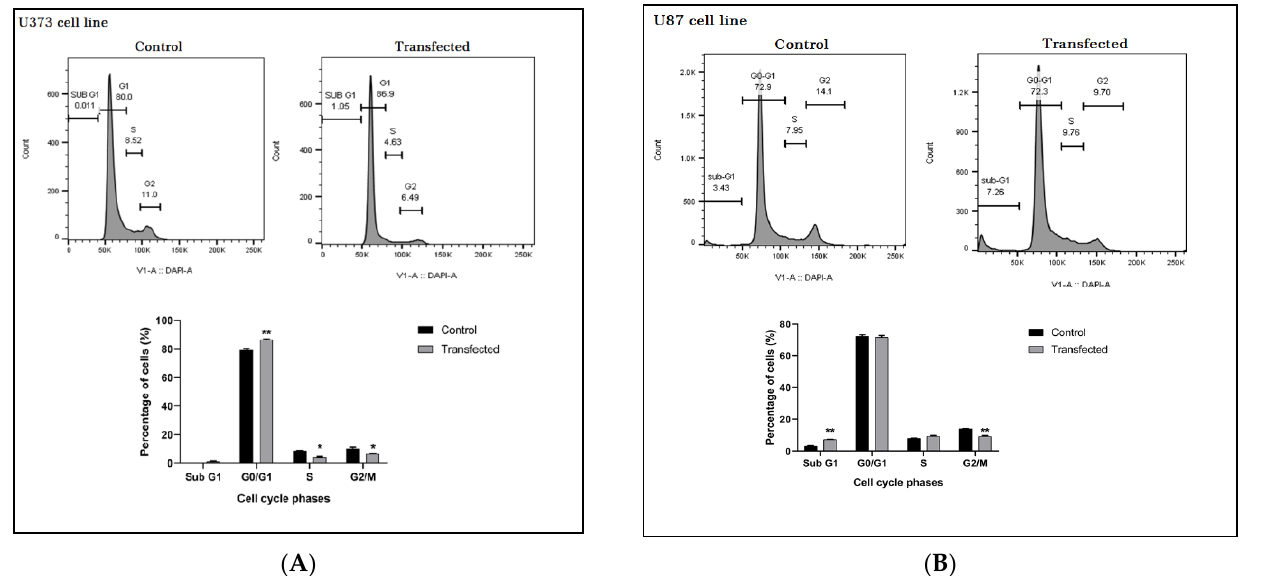
Figure 6. Effect of ZEB2 knockdown on the cell cycle distribution of U87 and U373 cell lines. ( A ) ZEB2-transfection increased